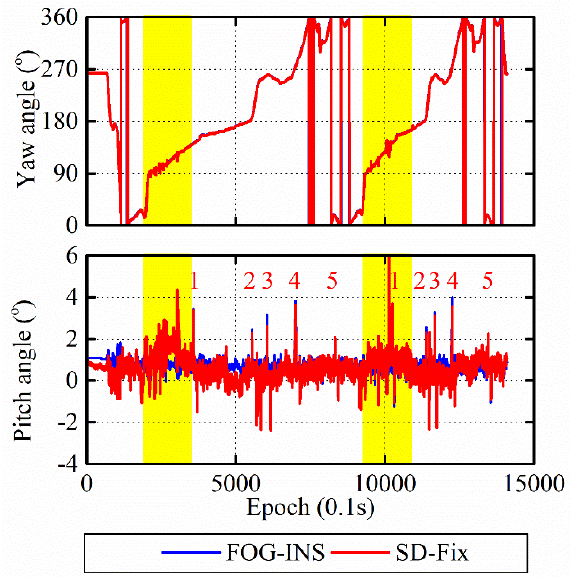
Figure 11. Comparison of attitude between fiber optic gyroscope inertial navigation system (FOG- INS) and SD-Fix.